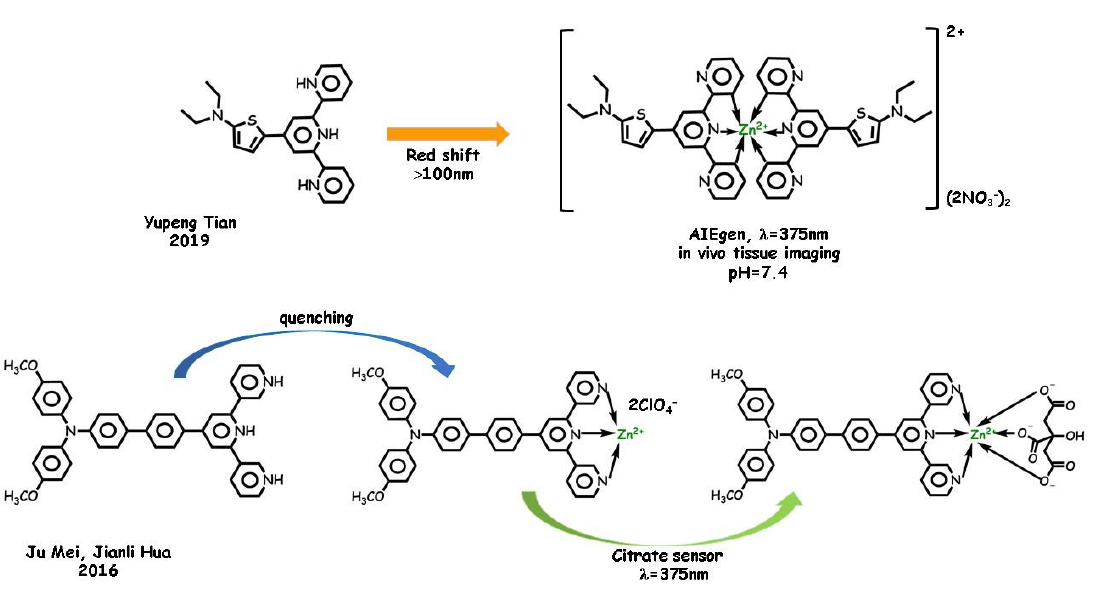
Figure 3. AIE behavior of zinc complexes from Tpy-type tridentate pincers.